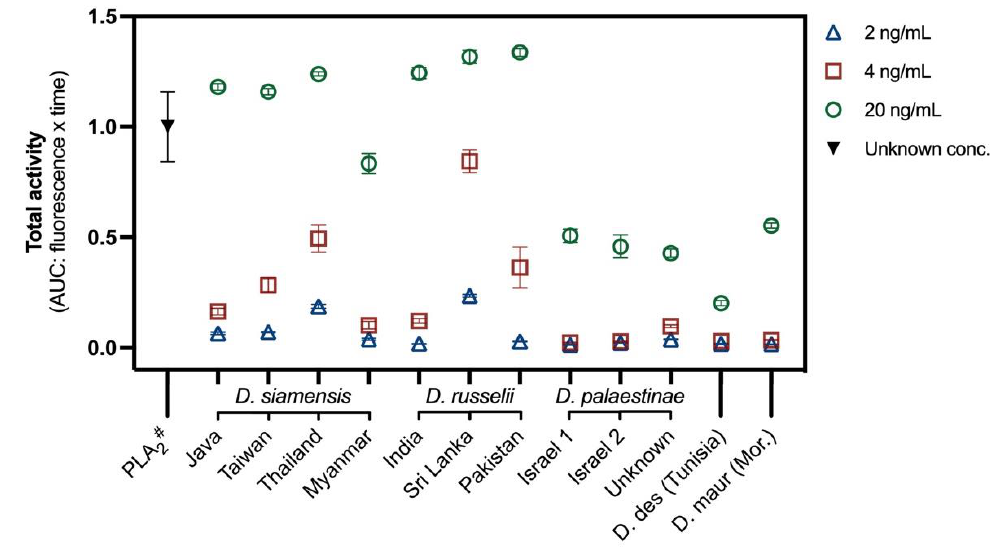
Figure 2. Enzymatic activity (represented as area under the curve (AUC: relative fluorescence units x time)) of 2, 4, and 20 ng/mL µg of Daboia venoms on phospholipase A 2 (PLA 2 )-specific fluorogenic substrate. Data are the mean with 95% confidence intervals of three replicates, normalised to the PLA 2 control (#kit-provided PLA 2 (from bee venom) of unknown concentration); D. des = D. deserti , D. maur = D. mauritanica , Mor. = Morocco.